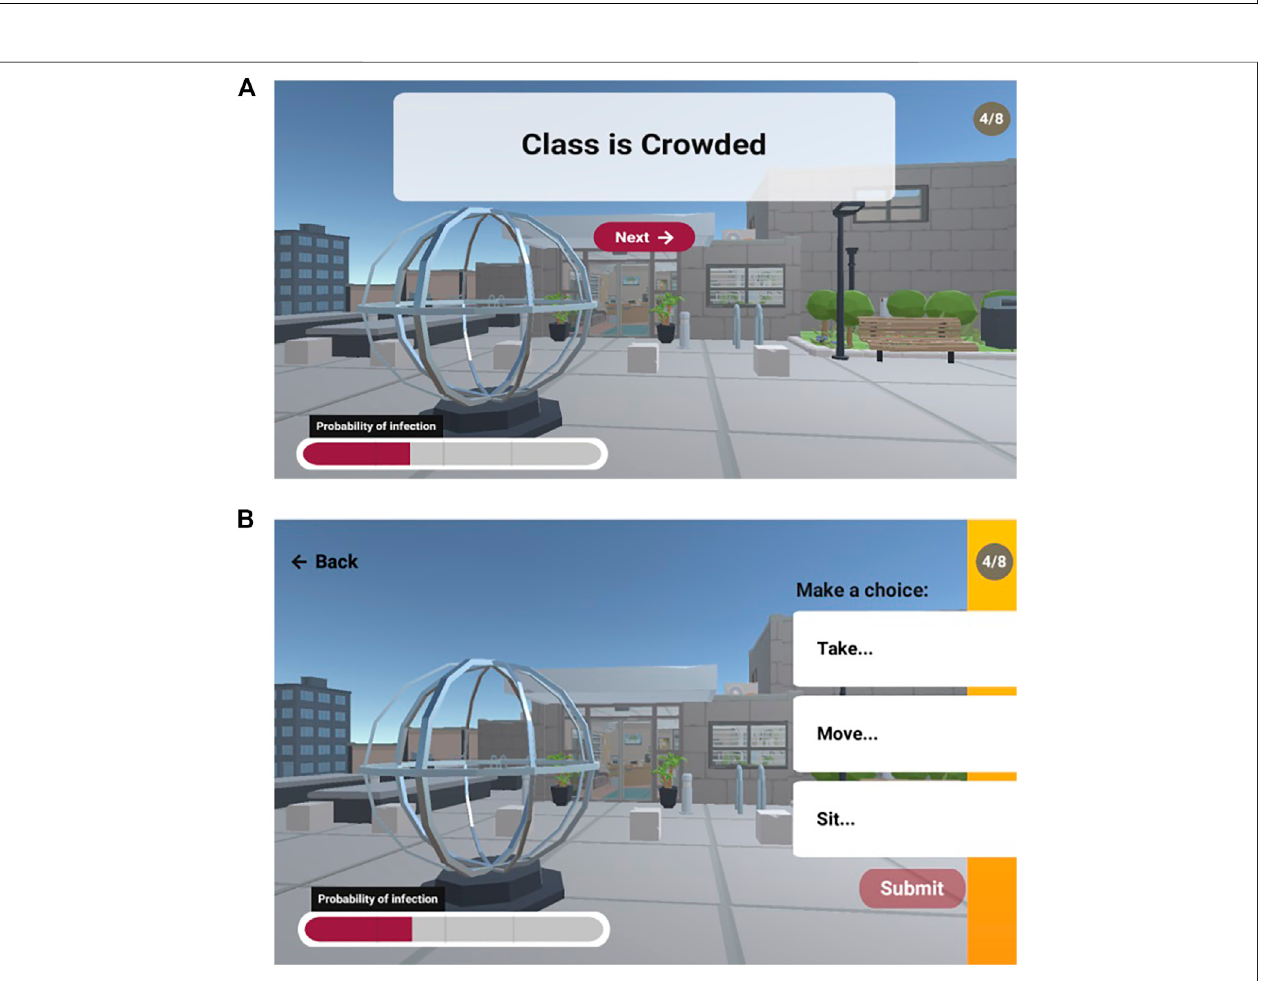
FIGURE 4 | Panel A sets up the situation, panel B shows the forced choice task.